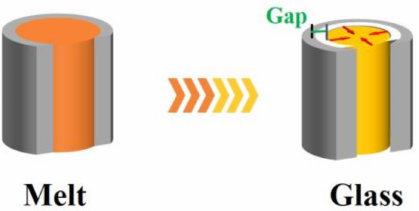
Figure 3. Isotropic shrinkage of PBMA nanorods from melt to glass. The orange and yellow cylinders represent the polymer melt, and the polymer glass, while the grey hollow cylinder represents the alumina nanopore.